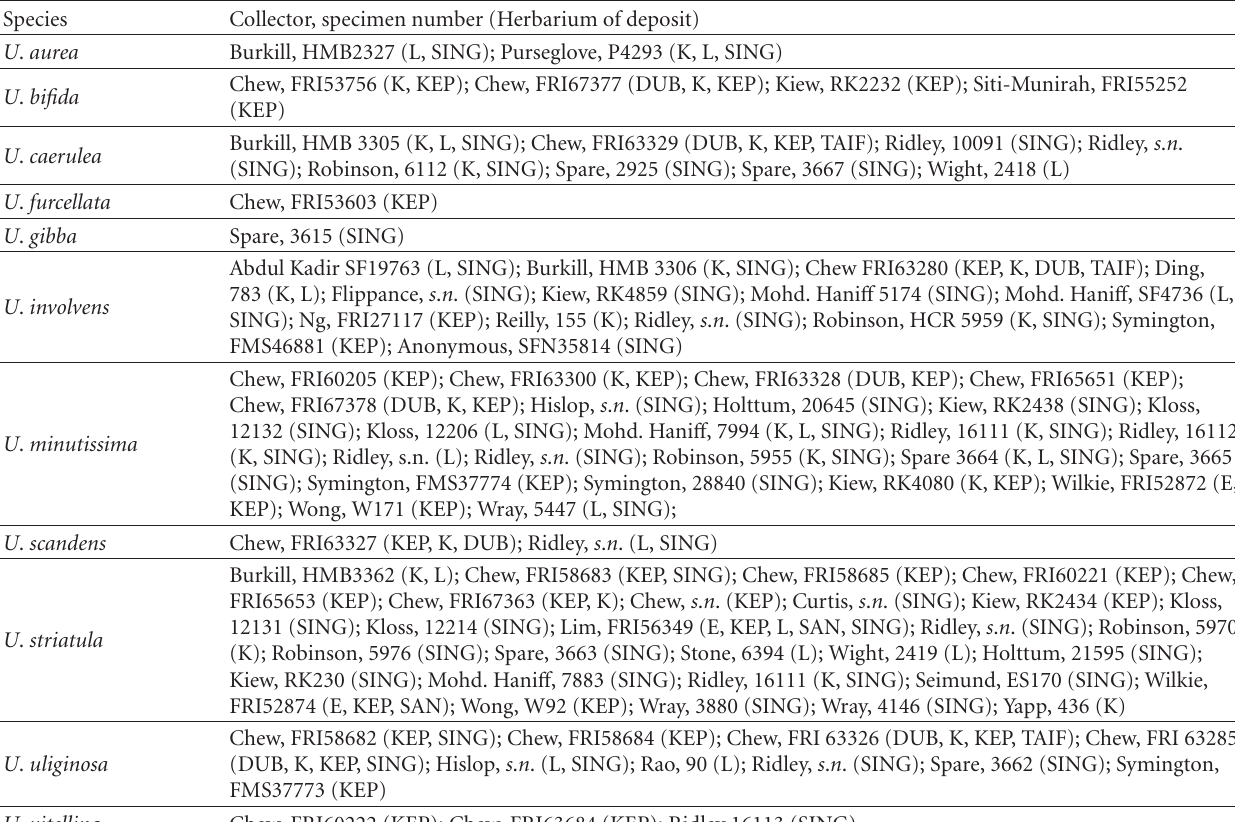
Table 2: Peninsular Malaysian Utricularia specimens from mountainous areas